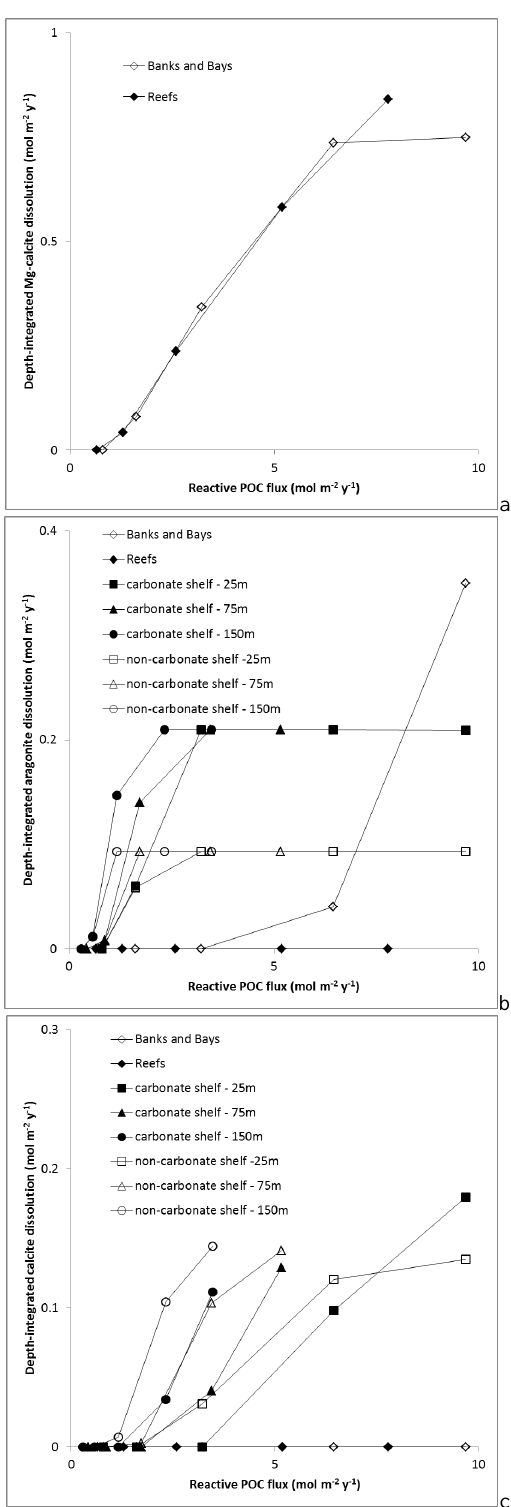
Fig. 3. Depth-integrated dissolution of (a) 15% Mg-calcite, (b) aragonite, and (c) calcite. Banks and bays ( ♦ ), reefs ( (cid:7) ), carbonate shelves: 25m ( (cid:4) ), 75m ( N ), and 150m ( • ); non-carbonate shelves: 25m ( (cid:3) ), 75m ( M ), and 150m ( ◦ ). 15% Mg-calcite present only in reefs and banks and bays.